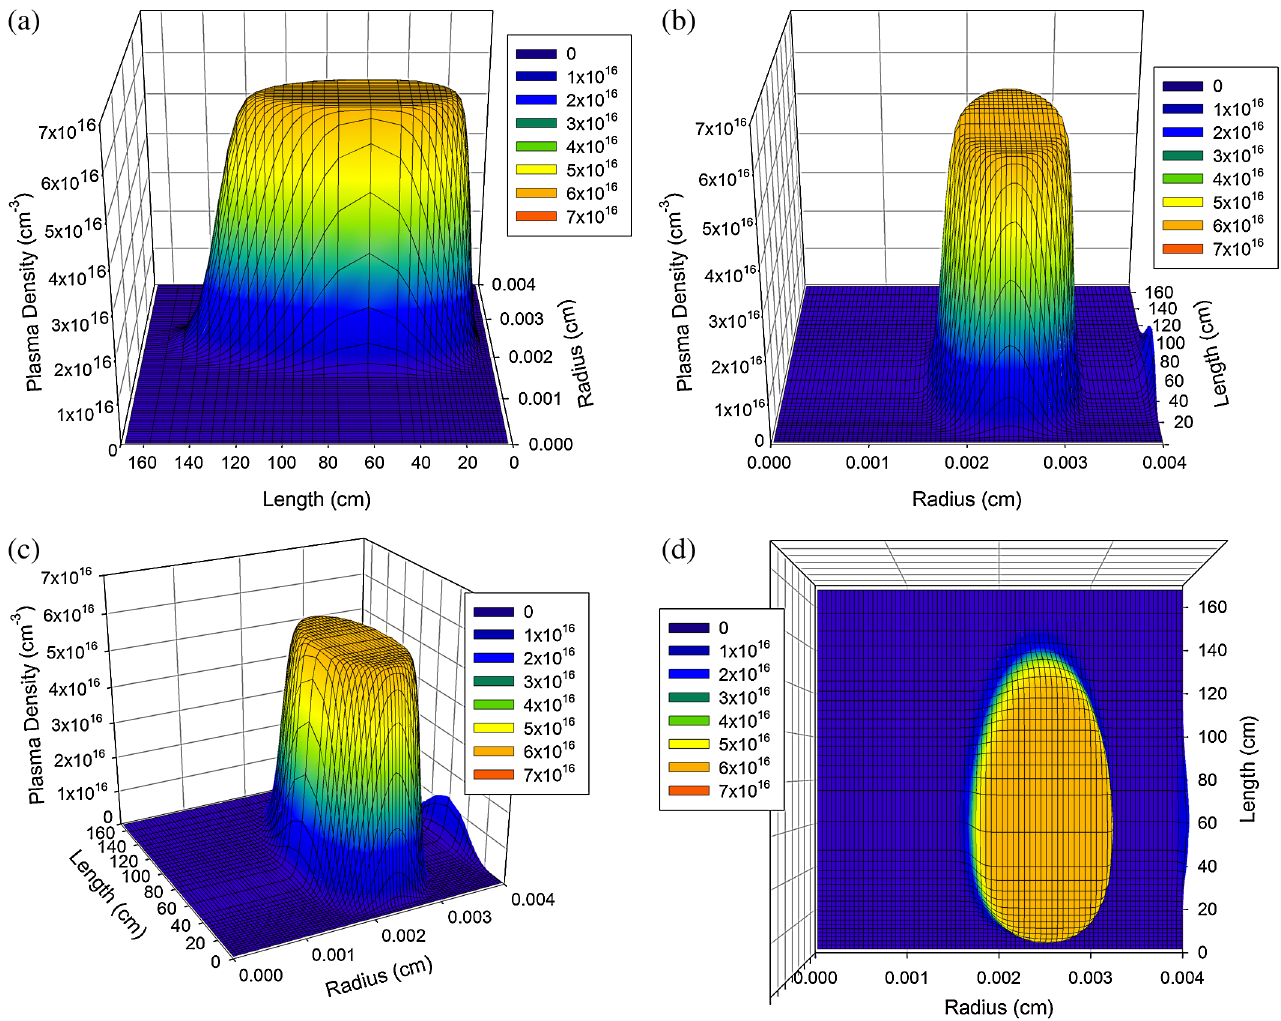
FIG. 10. 3D plots of plasma density distribution for the case of a peak laser intensity of 5 (cid:4) 10 14 W = cm 2 . The input laser beam HWHM ¼ 2 cm . (a) Showing length of plasma channel. (b) Showing width of plasma channel. (c) Showing 3D perspective. (d) Showing length and width of